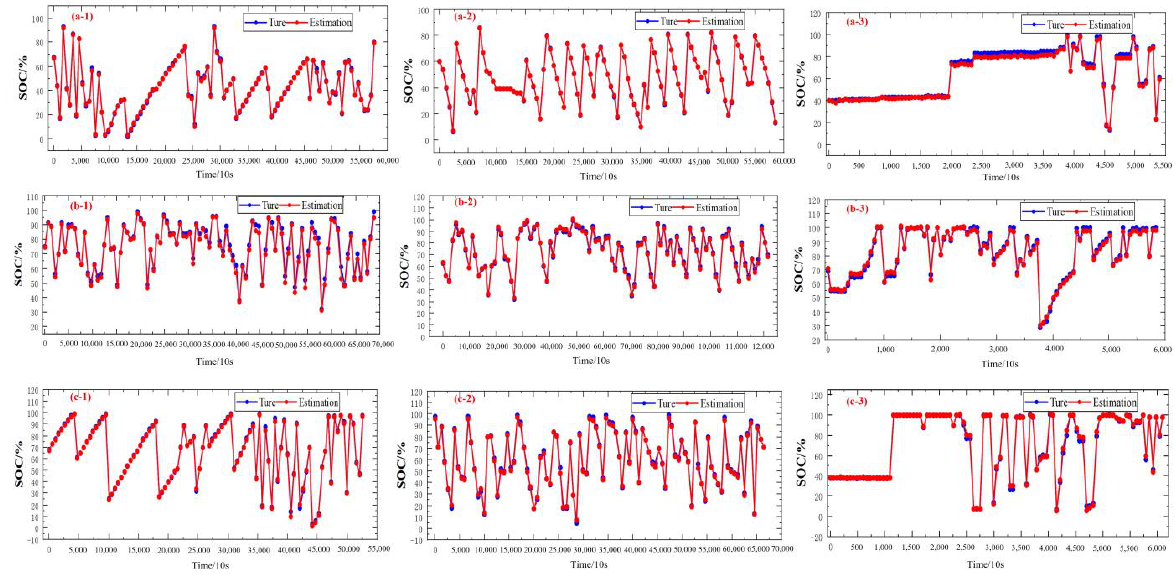
Figure 9. SOC estimation results under different validation cases. ( a-1 , a-2 , a-3 ) SOC estimation results of vehicle a under three different working conditions; ( b-1 , b-2 , b-3 ) SOC estimation results of vehicle b under three different working conditions; ( c-1 , c-2 , c-3 ) SOC estimation results of vehicle c under three different working